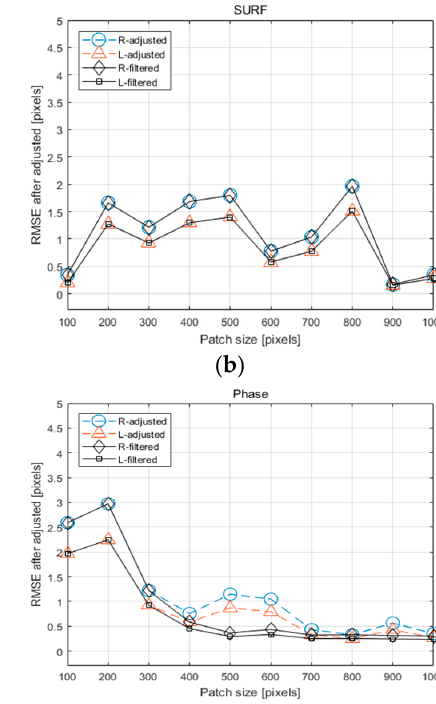
Figure 20. Reprojection errors (across-track Kompsat-3A original—after adjustment): ( a ) HARRIS–